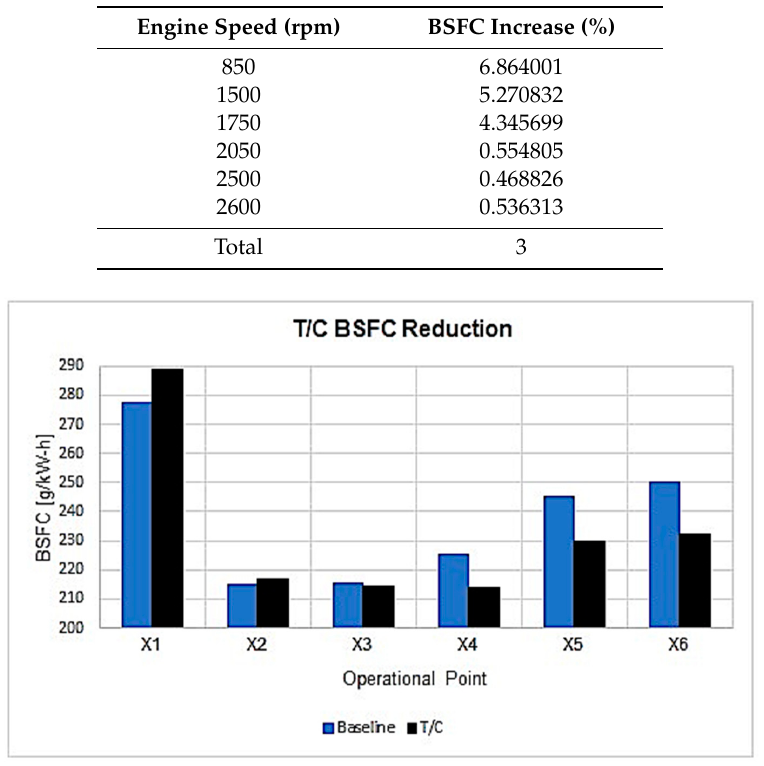
Figure 18. T / C system BSFC reduction. Figure 18. T/C system BSFC reduction.